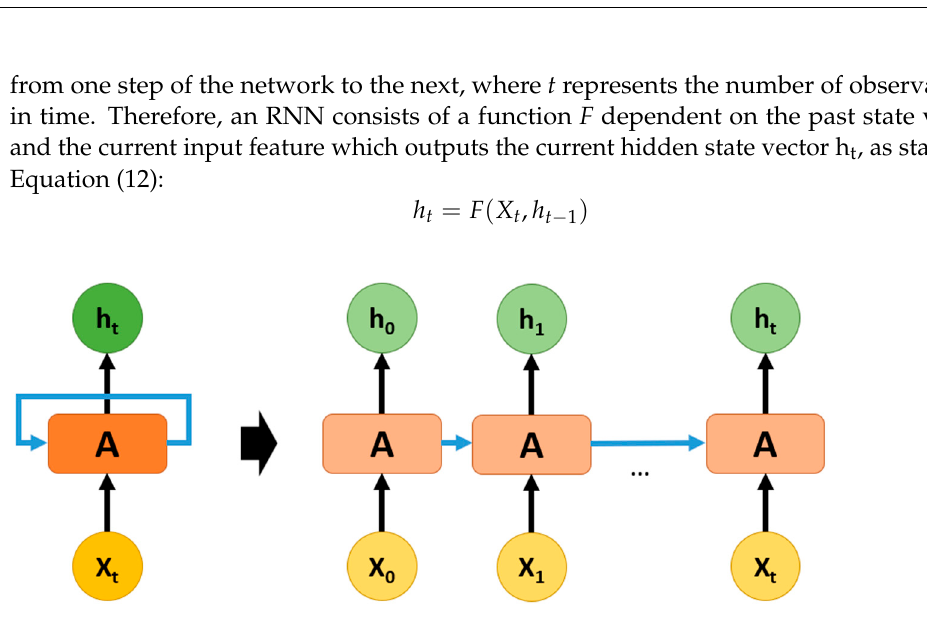
Figure 13. Implemented classification network. ( a ) Python code; ( b ) architecture of neural network. With the forget layer, operated by a sigmoid function, the magnitude of the gradient of LSTM does not decrease, thereby avoiding the gradient problem [54]. The output of the forget layer is between 0 and 1 for each value in the cell state, where a 0 represents to completely forget the value while a 1 represents to totally keep the state as shown in Equa- tion (14): 𝑓 (cid:3047) = 𝜎(cid:3435)𝑊 (cid:3033) ∙ (cid:4670)ℎ (cid:3047)(cid:2879)(cid:2869) , 𝑋 (cid:3047) (cid:4671) + 𝑏 (cid:3033) (cid:3439)